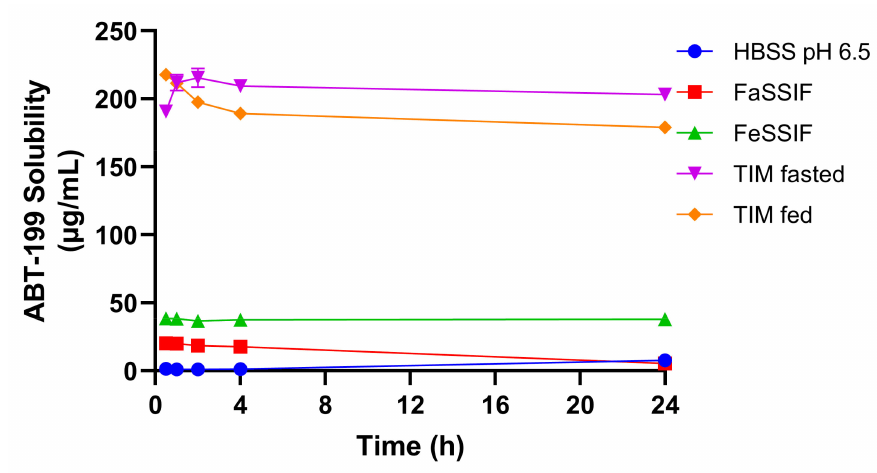
Figure 6. ABT-199 solubility in different biorelevant media over 24 h incubation.